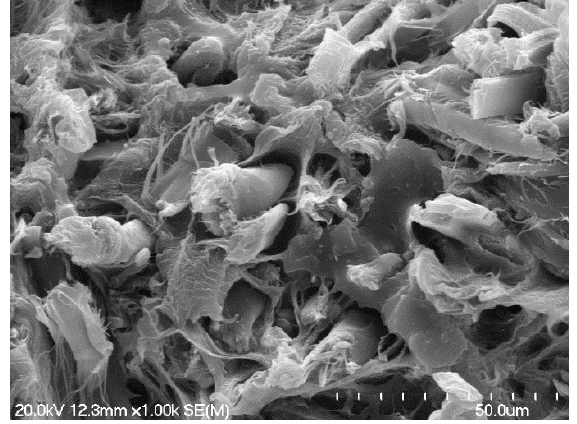
Figure 16. The 30 wt % hemp filament fracture surface, showing fiber alignment and deformation of matrix.